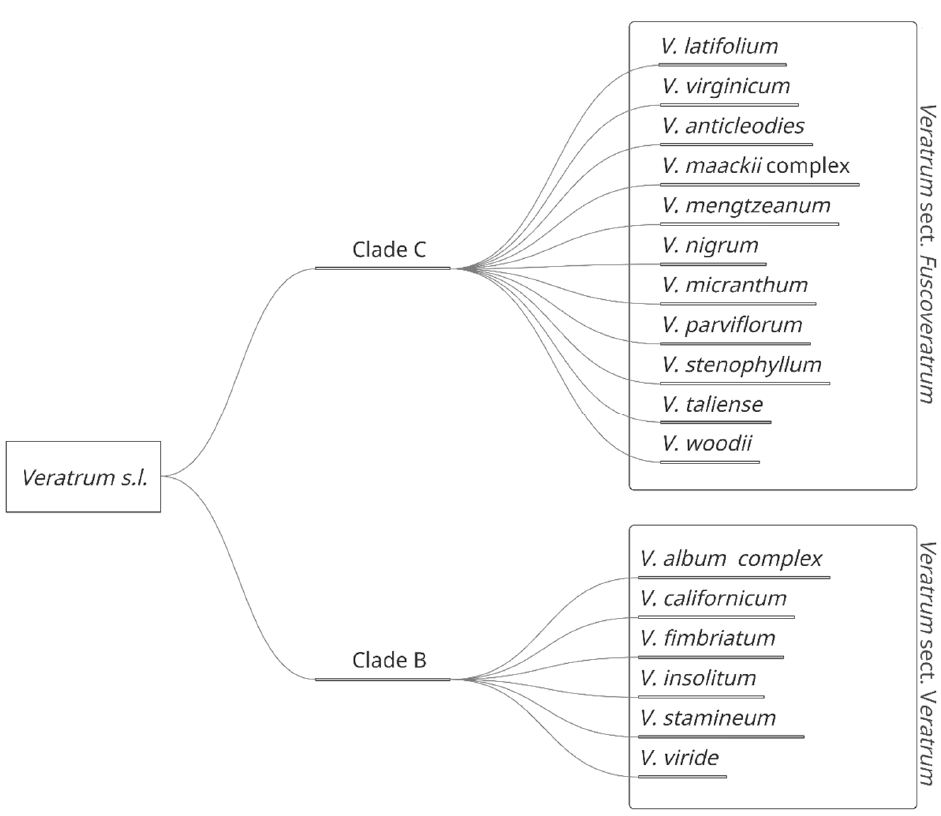
Figure 1. Veratrum spp. separated by classification in Veratrum sect. Fuscoveratrum and Veratrum sect. Veratrum.